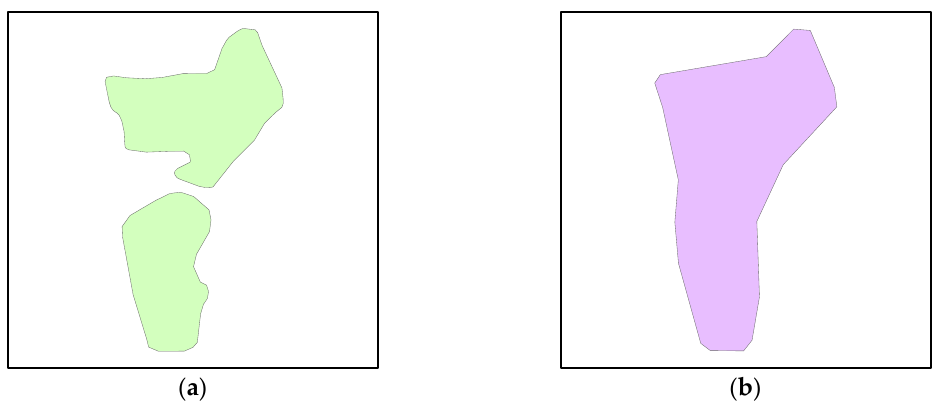
Figure 6. The lake at different scales: ( a ) the lake in scale of 1:10,000 and ( b ) the lake in scale of 1:50,000.